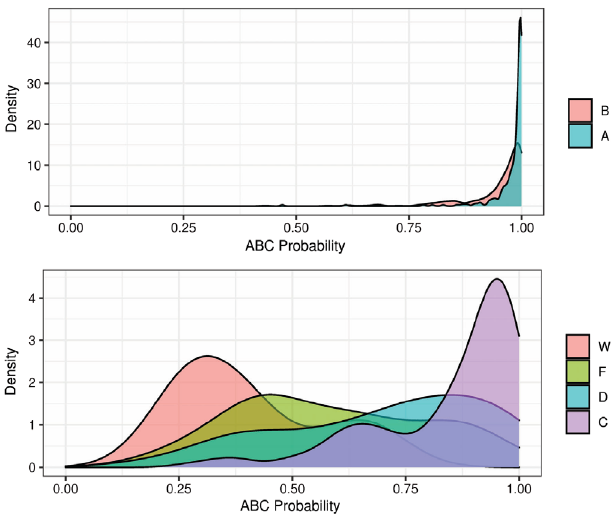
FIG. 2. Predicted probability of earning an A, B, or C for sample 1 disaggregated by the actual grade received in the class. The figure plots the probability density of each outcome. The order of the peaks in the lower figure from left to right is W, F, D,